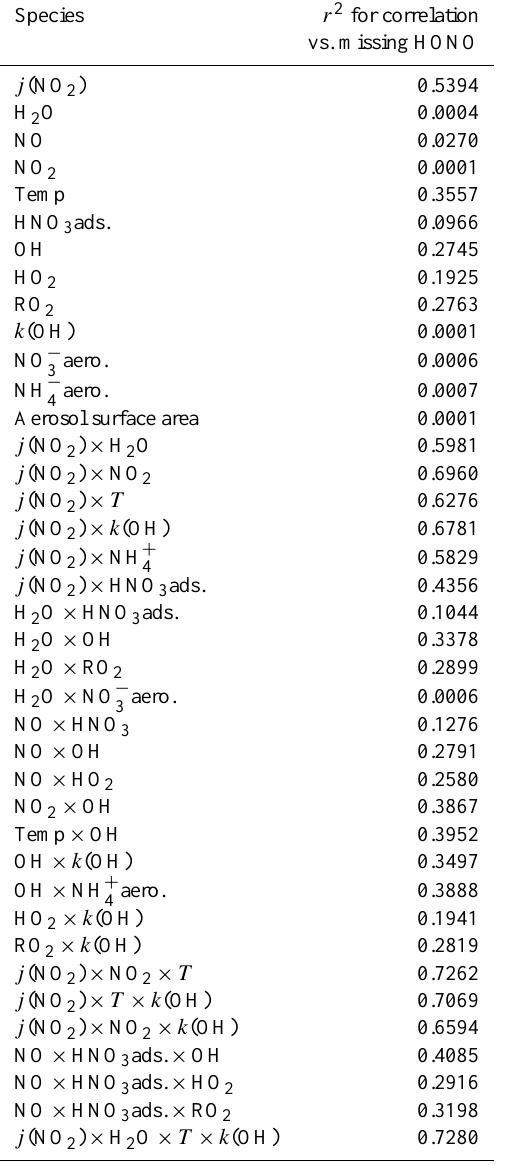
Table 1. Correlation coefficients ( r 2 ) for plots between vari- ous species measured during ClearfLo (and their products), using j (NO 2 ) as a proxy for radiation, and the missing HONO source from the model (using the model with all additional sources). The species used were chosen using the method described in the text. See Fig. S1 in the Supplement for